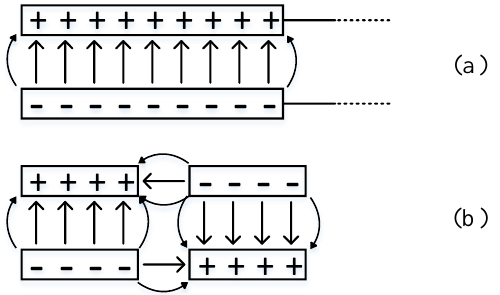
Figure 2. Illustration of the electrical field between capacitor plates.